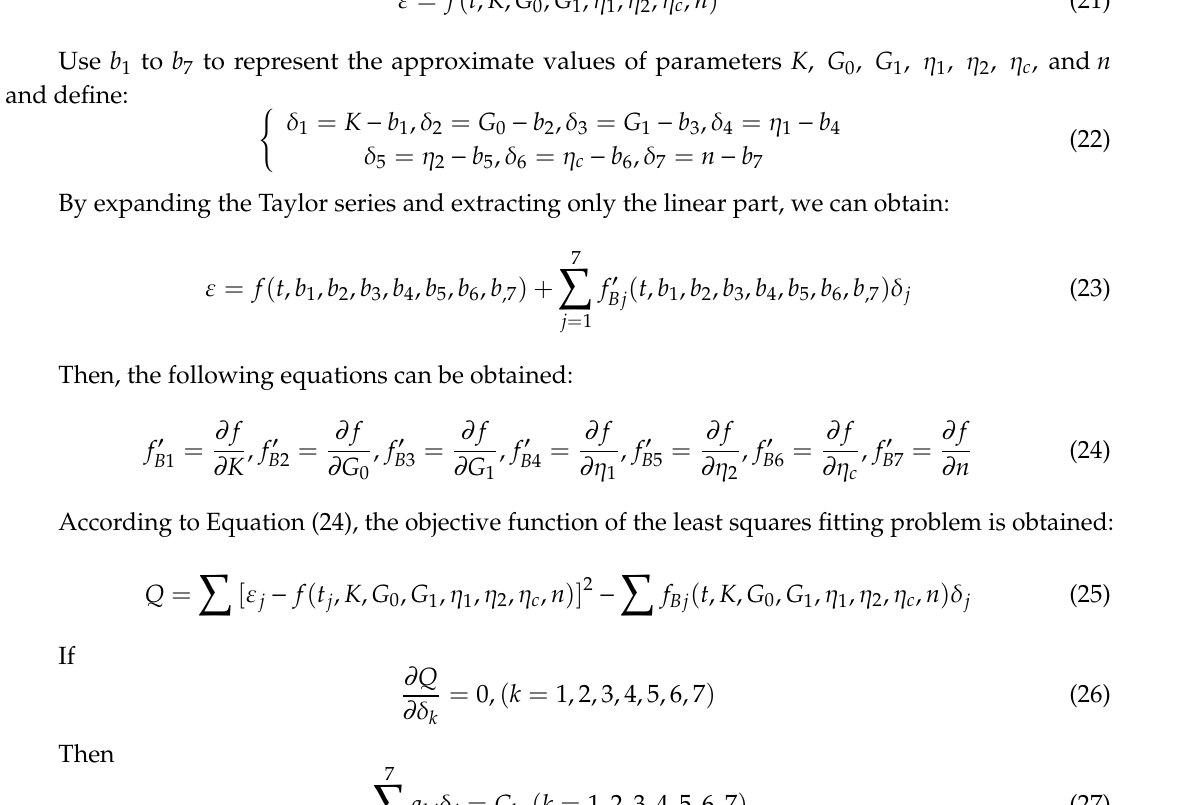
Table 3. The creep parameters σ s